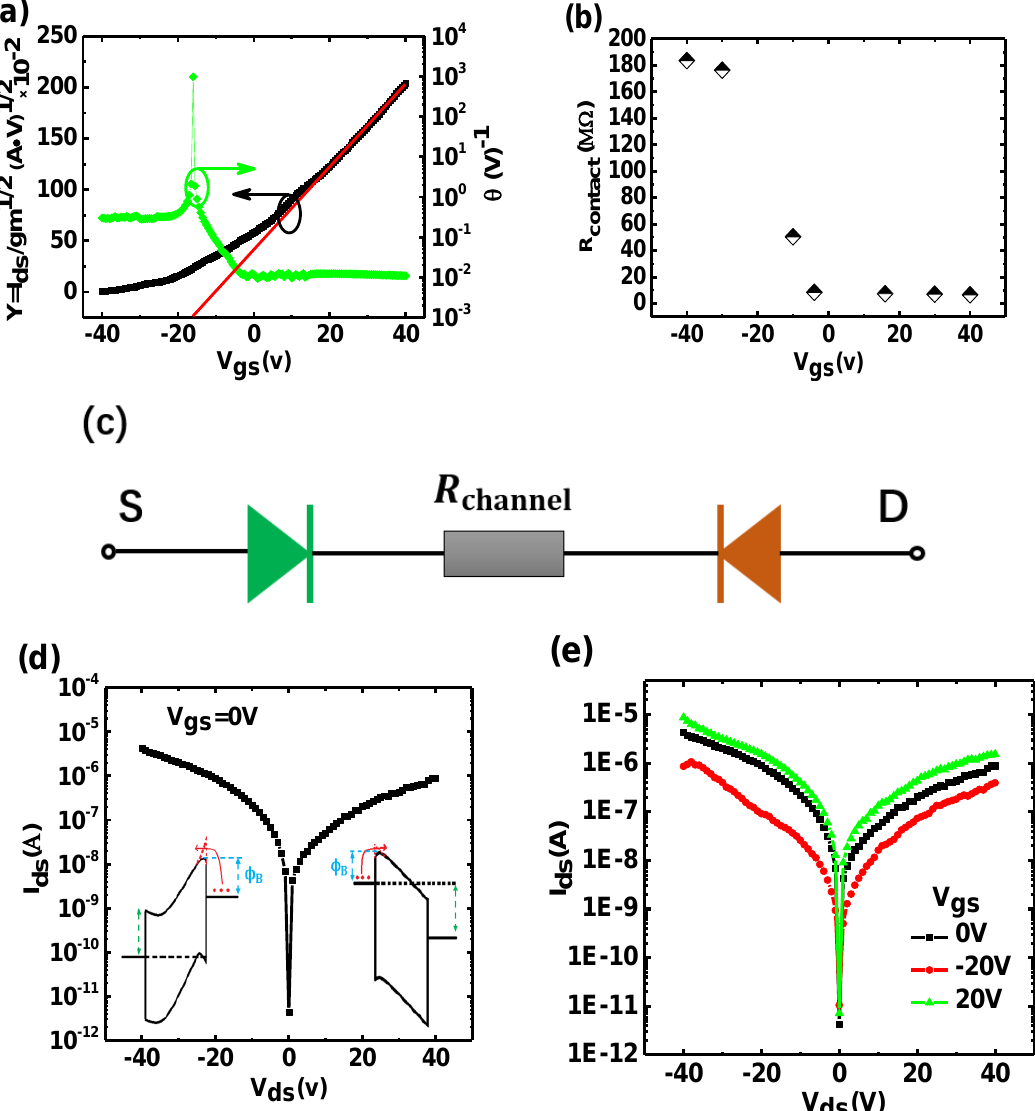
Figure 2. ( a )The relationship curve between the mobility degradation coe ffi cient θ and V gs (green) and Y-function as function of V gs (black). ( b ) The contact resistance extracted from the mobility degradation curve. ( c ) The equivalent diode model of current flowing. ( d ) I–V characteristics at V gs = 0 V and the energy band diagram(inset). ( e ) I–V characteristics at di ff erent gate voltage.